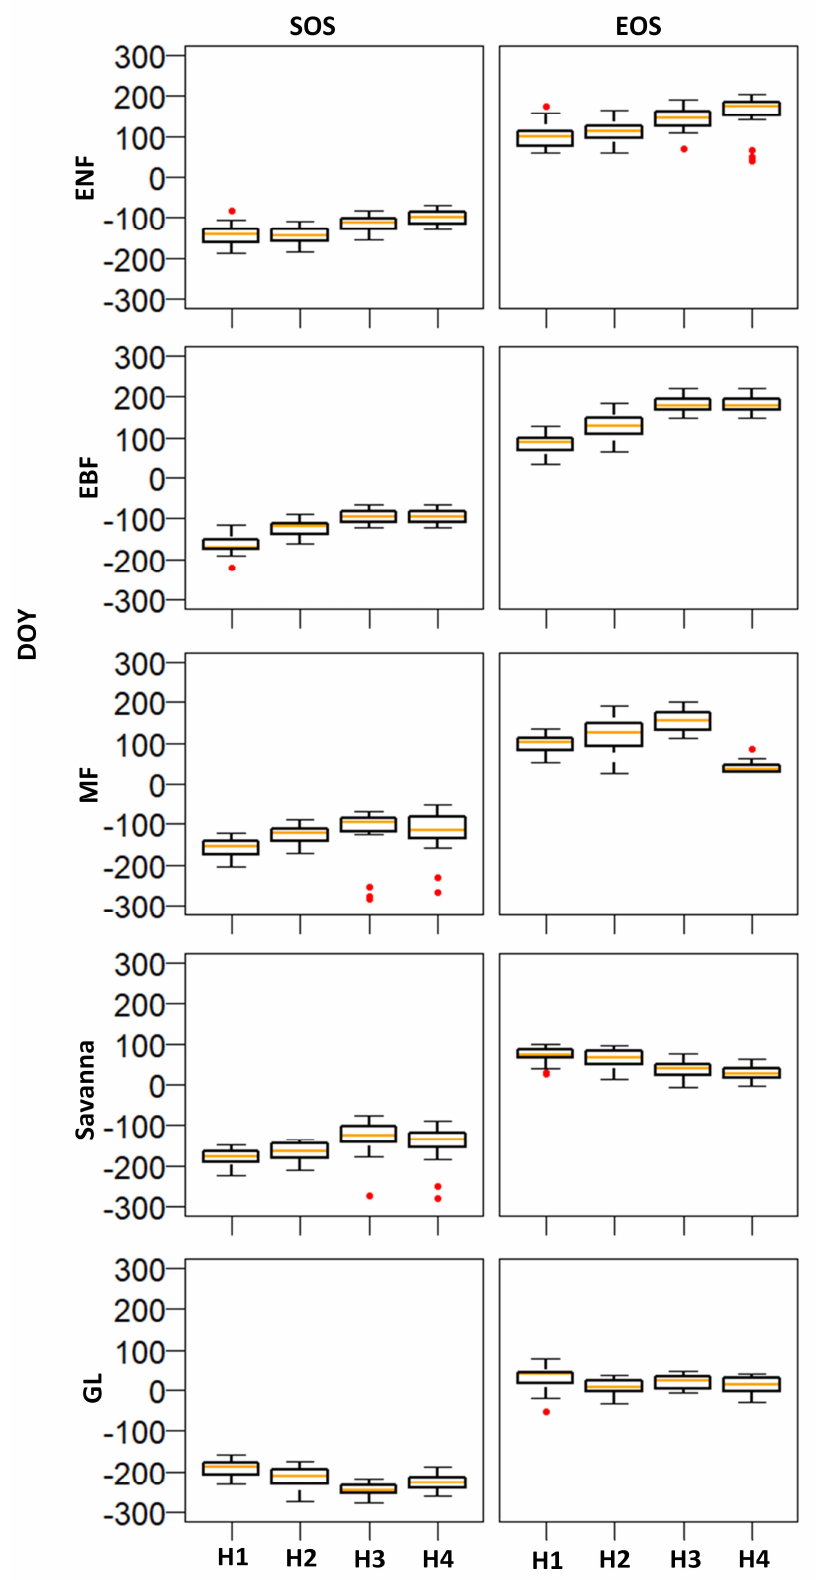
Figure 3. Phenometrics distribution along the elevation gradient across the vegetation types. The positive and negative values indicate starting in the current year and ending in the next year, respectively. The x -axis labels are the subzones divided along the altitudinal gradient of the vegetation types.